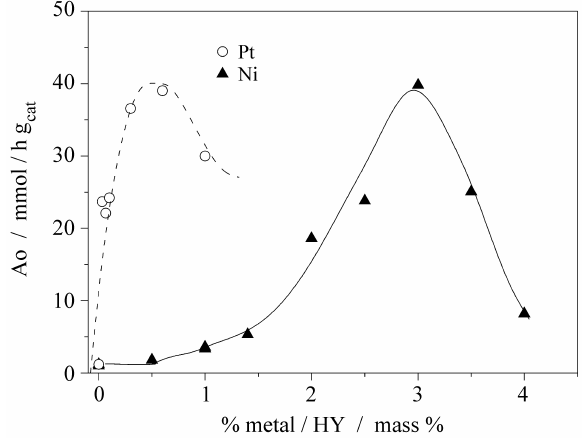
Figure 4. Initial activity (Ao) of catalysts Ni/HY and Pt/HY as a function of the metal content.